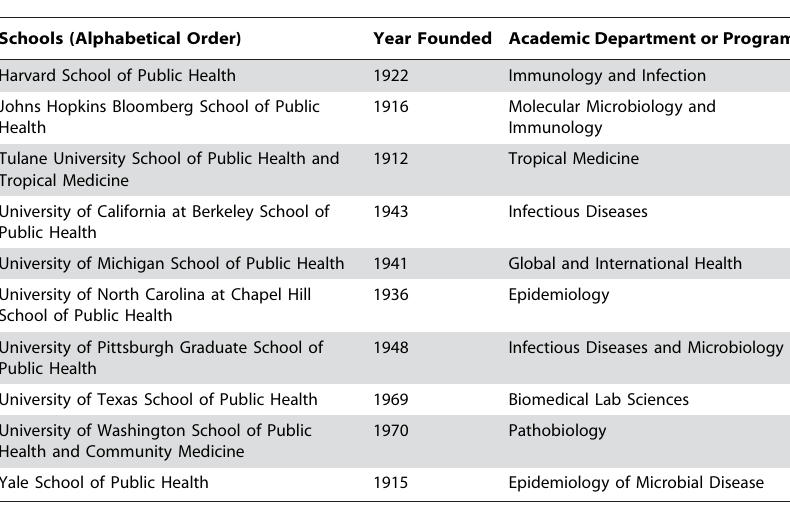
Table 1. US Accredited Public Health Schools Founded before 1970 with Academic Departments Devoted to Infectious and Tropical Diseases.